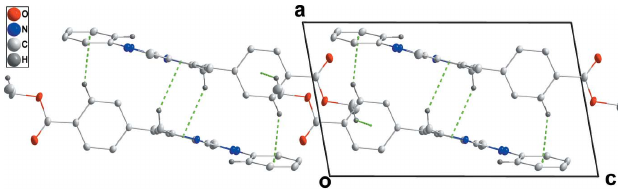
Figure 2 Packing viewed along the b -axis direction with C—H (cid:3)(cid:3)(cid:3) (cid:2) (ring) inter- actions shown as dashed lines.